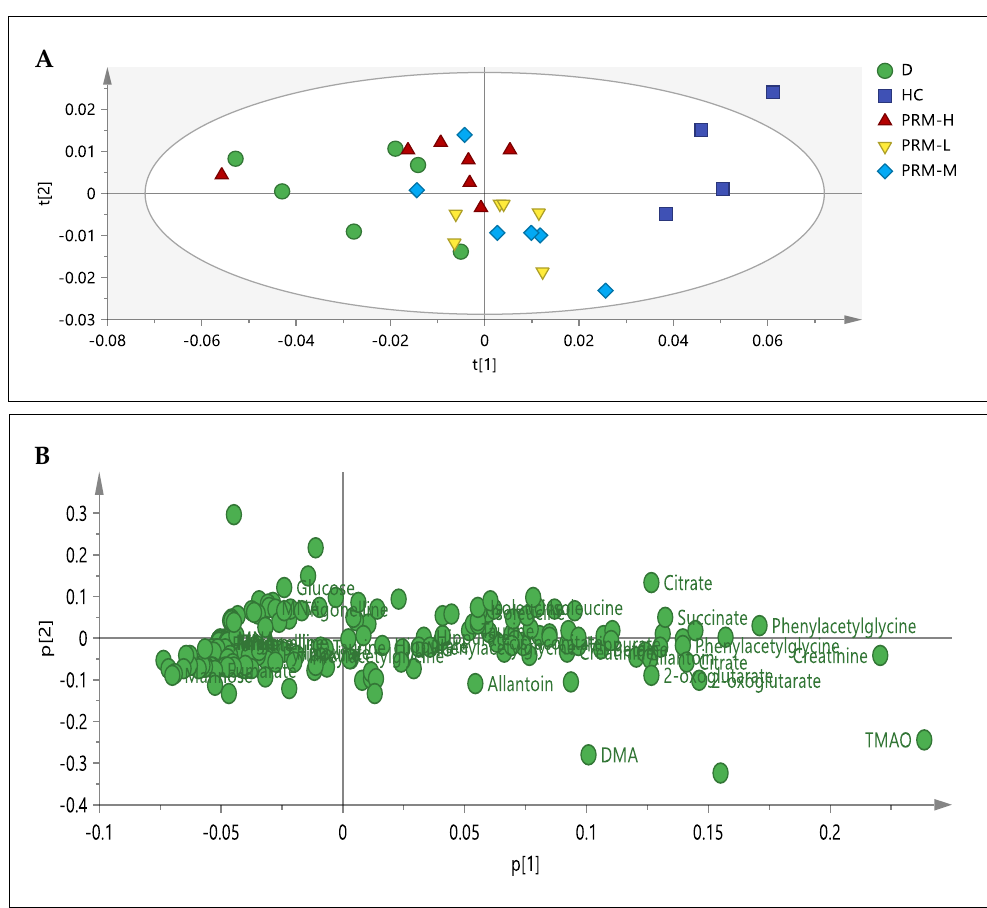
Figure 1. Principle component analysis (PCA) M2. Score plot ( A ) and loading scatter plot ( B ) obtained using 1 H-NMR from simvastatin (D), hyperlipidemia (HC), polyphenol-rich mixture high dose, 500 mg/kg (PRM-H), polyphenol-rich mixture medium dose, 250 mg/kg (PRM-M) and polyphenol-rich mixture low dose, 150 mg/kg (PRM-L).